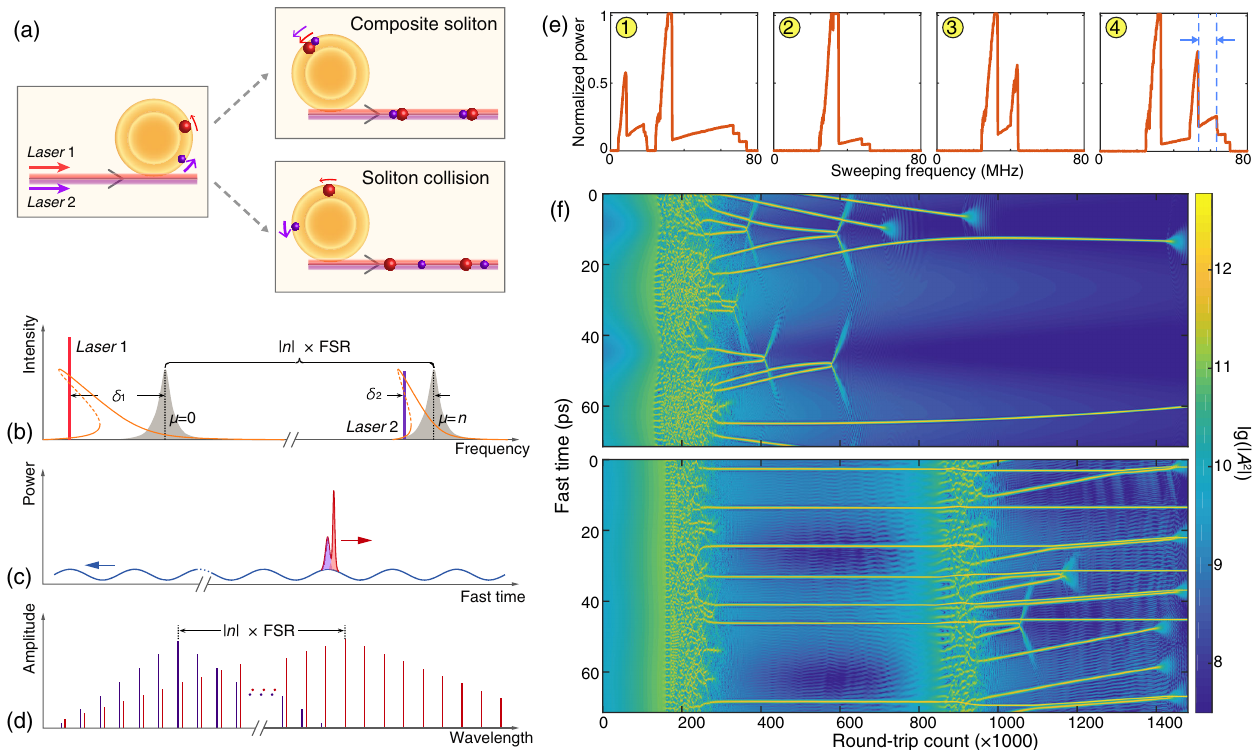
FIG. 1. Multistability dynamics in a dual-pumped Kerr resonator. (a) An illustration of the two possible dynamic states enabled by bichromatically pumped multistability, namely the composite soliton and the soliton collision. (b) The concept of the bichromatic- pumping-enabled multistability in the frequency domain. (c) In the time domain, the two solitons (bound in the figure) travel at a velocity different from that of the intracavity lattice traps. (d) The two microcombs which correspond to the two distinct DKSs. (e) Experimentally generated comb power as the two lasers are swept across the resonances with a detuning difference Ω . The four labeled panels respectively correspond to (1) Ω = 2 π ¼ − 20 MHz, both the soliton steps driven by the two lasers are shown separately, (2) Ω = 2 π ¼ 0 MHz, only one soliton state exists, (3) Ω = 2 π ¼ 10 MHz, the primary-pumped soliton state disappears after the secondary pump is coupled in efficiently, (4) Ω = 2 π ¼ 20 MHz, the coexistence of distinct soliton steps shows between the dashed lines. (f) The simulated intracavity intensity evolutions with conventional dual-pumped soliton lattice traps (upper panel, δ 1 ¼ δ 2 ) and bichromatic- pumping-enabled multistability (lower panel, δ 1 − δ 2 ¼ 70 κ ). The relative drifting of the DKS driven by the secondary laser in the lower panel is a result of the different intrinsic soliton group velocities due to the FSR difference between the two pumped resonances. The secondary solitons annihilate close to the end of the simulation because the effective detuning reaches the end of the secondary soliton existence range, which is much narrower than the primary soliton existence range due to the lower pump